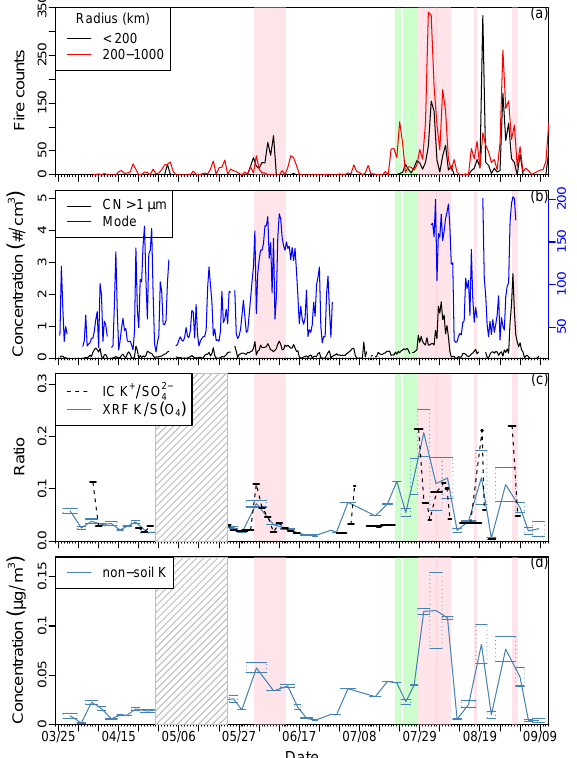
Fig. 6. Time series of co-located measurements of (a) ACSM OM, SO 4 , and NO 3 mass concentrations, (b) ACSM ion signals of m / z 57, 60, and 73 mass fragments, (c) cosine angle distance of ACSM mass spectra to laboratory spectra from Shilling et al. (2009) and ratio of ion signals of m / z 44 to m / z 43, and (d) BC number concen- trations measured by the SP2. Periods during which ACSM OM is below detection limit is removed from panel (c) . Pink indicates pe- riods with biomass burning influence, green indicates periods with primarily non-burning biogenic influence, and no colour indicates periods with other (primarily anthropogenic combustion) influence, as selected by criteria defined in the text.